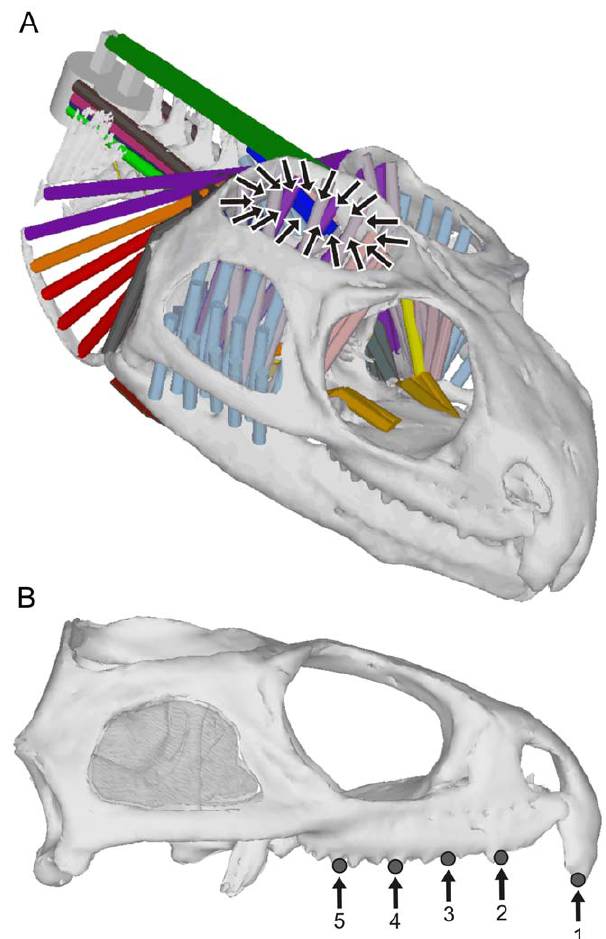
Figure 2. MDA model. A. Multibody computer model used to calculate the muscle, joint and biting forces for a series of biting simulations. Black arrows represent the location and direction of the fascial force vectors applied to the finite element model over one temporal opening. B. Bite locations. Bilateral (biting on both sides simultaneously) and unilateral biting (biting on one side only) at locations 2–5; bilateral biting only at location 1; ripping bites at location 2 only. Skull measures approximately 68 mm long from the tip of the premaxilla to the posterior end of the quadrate